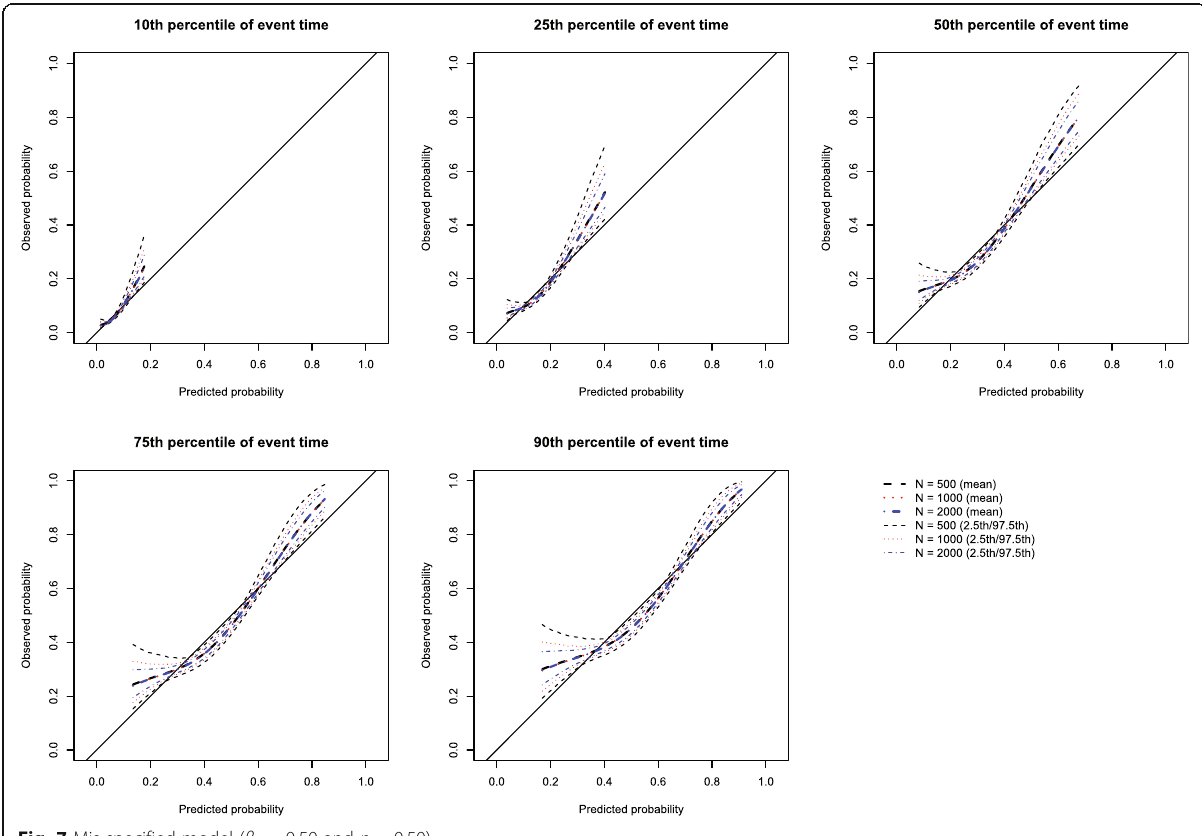
Fig. 7 Mis-specified model ( β 1 = 0.50 and p =